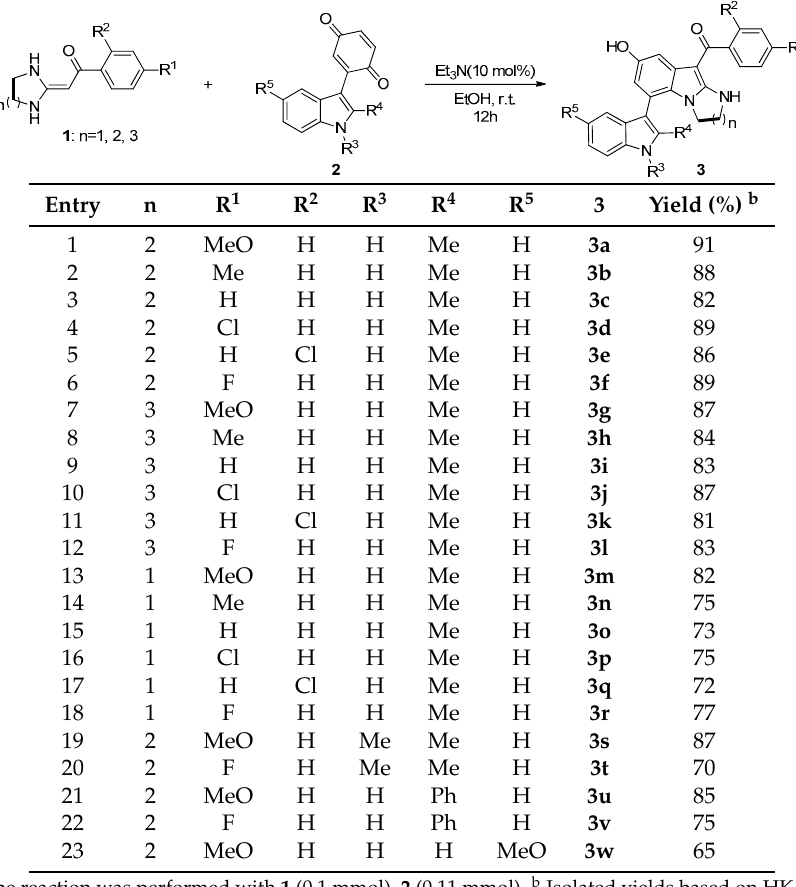
Table 2. Preparation of the of 3,7 ′ -bisindole derivatives a